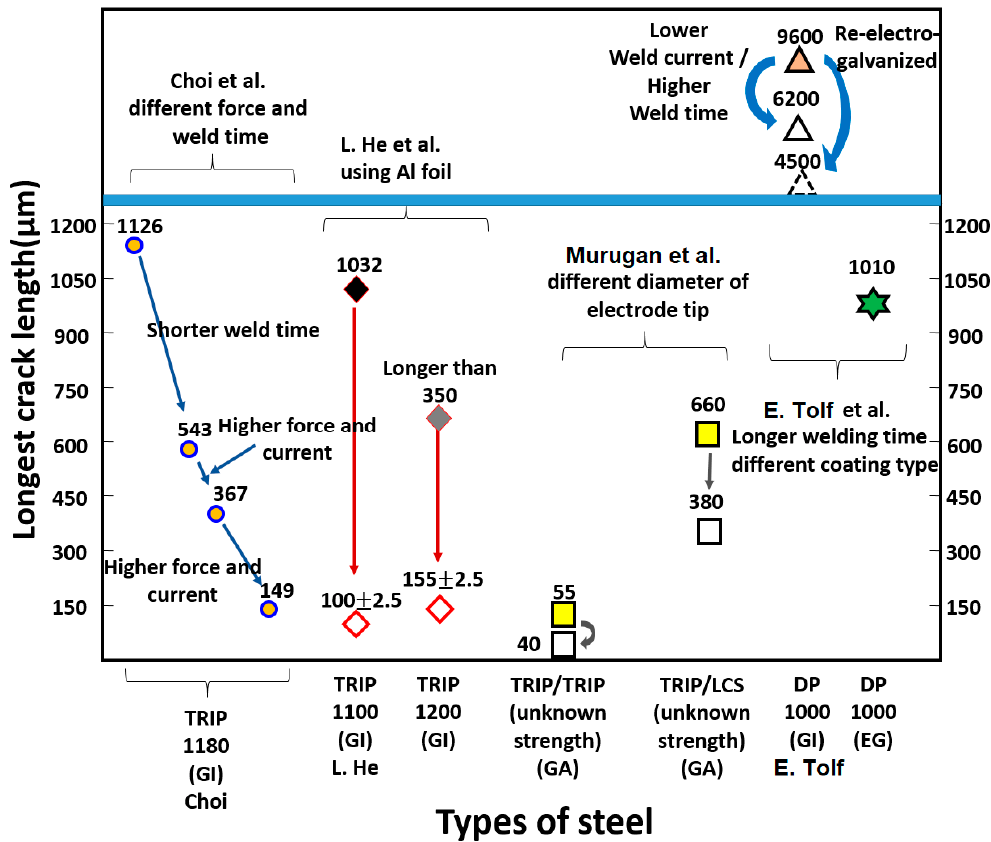
Figure 9. Studies about decreasing LME cracks on several types of TRIP and Dual-Phase (DP)